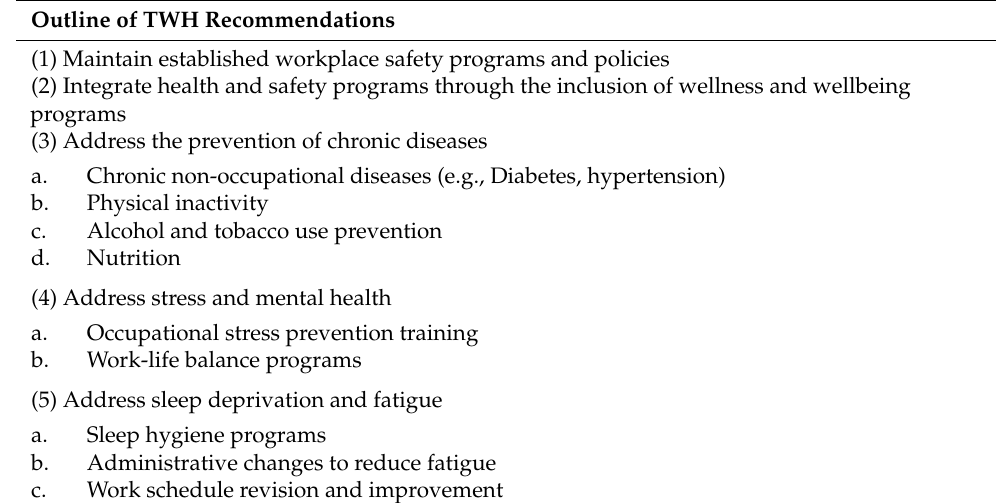
Table 3. Recommendations for the implementation of a TWH approach at Pantaleon. Outline of TWH